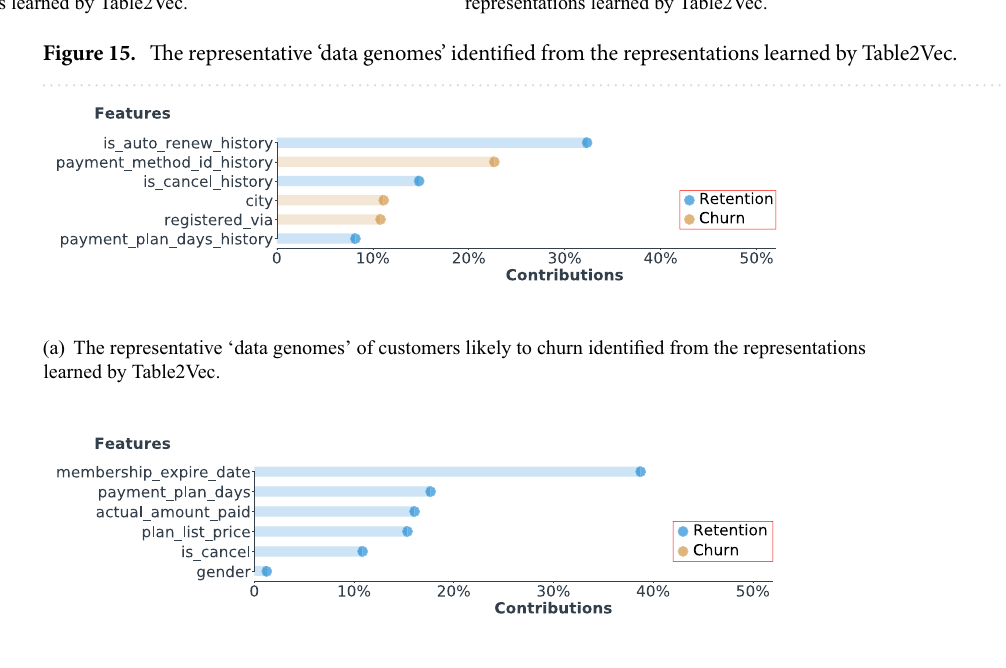
(b) The representative ‘data features’ of customers likely to churn learned by XGBoost. Figure 16. The comparison of Table2Vec and XGBoost in terms of their learned customer data